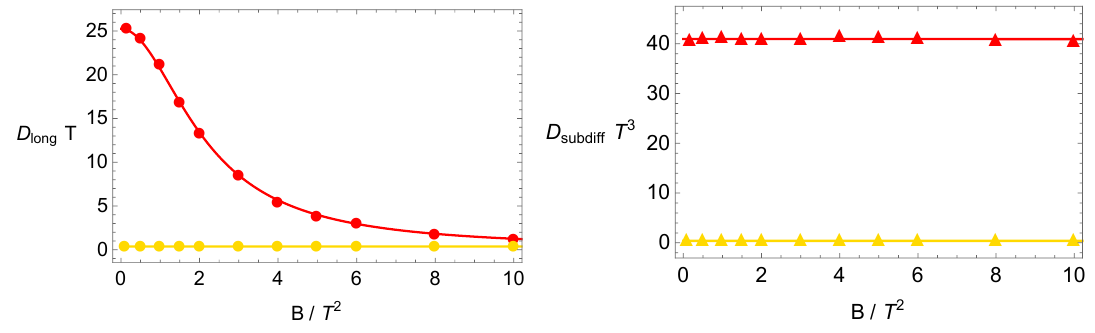
Figure 11 . The diffusive parameters for the longitudinal diffusive (circles) and subdiffusive (tri- angles) modes at finite charge density and magnetic field. Yellow lines are for µ/T = 5 while red lines for µ/T = 0 . 5 . The fluctuations of the red triangles are due to numerical